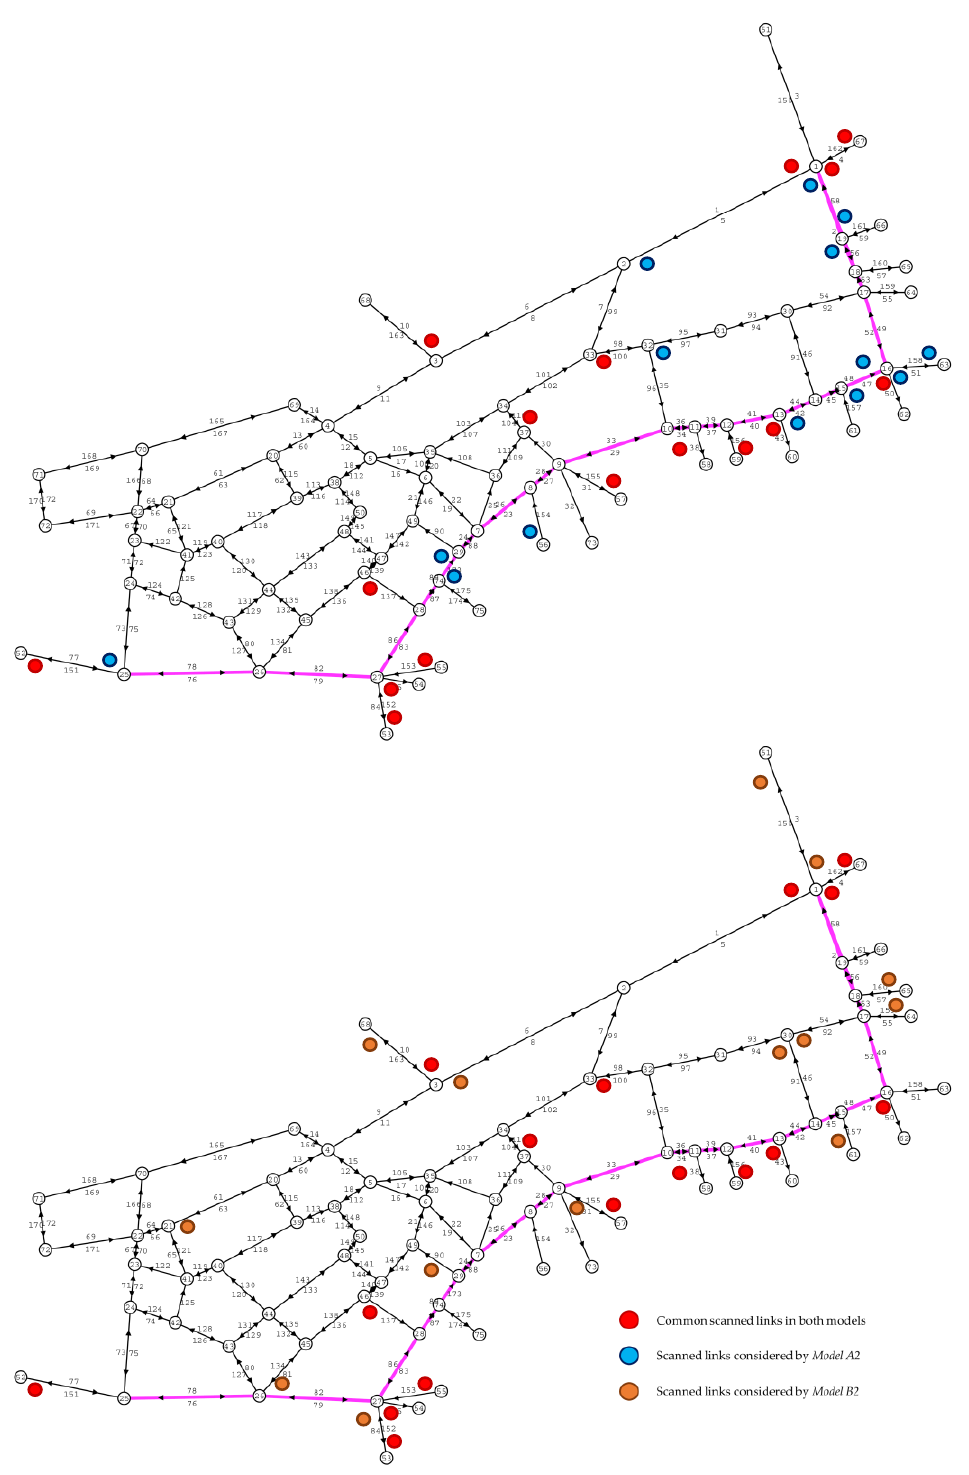
Figure 14. Upper figure: Optimal sensor locations considering 𝑘 = 3, 𝐹 𝑡ℎ𝑟𝑒𝑠 = 10, and all links as candidates to be scanned; Lower figure: Optimal sensor locations considering 𝑘 = 3, 𝐹 𝑡ℎ𝑟𝑒𝑠 = 10, and a certain set non-candidate scanned links ( 𝑁𝑆𝐿 ) of links as no candidates to be scanned.